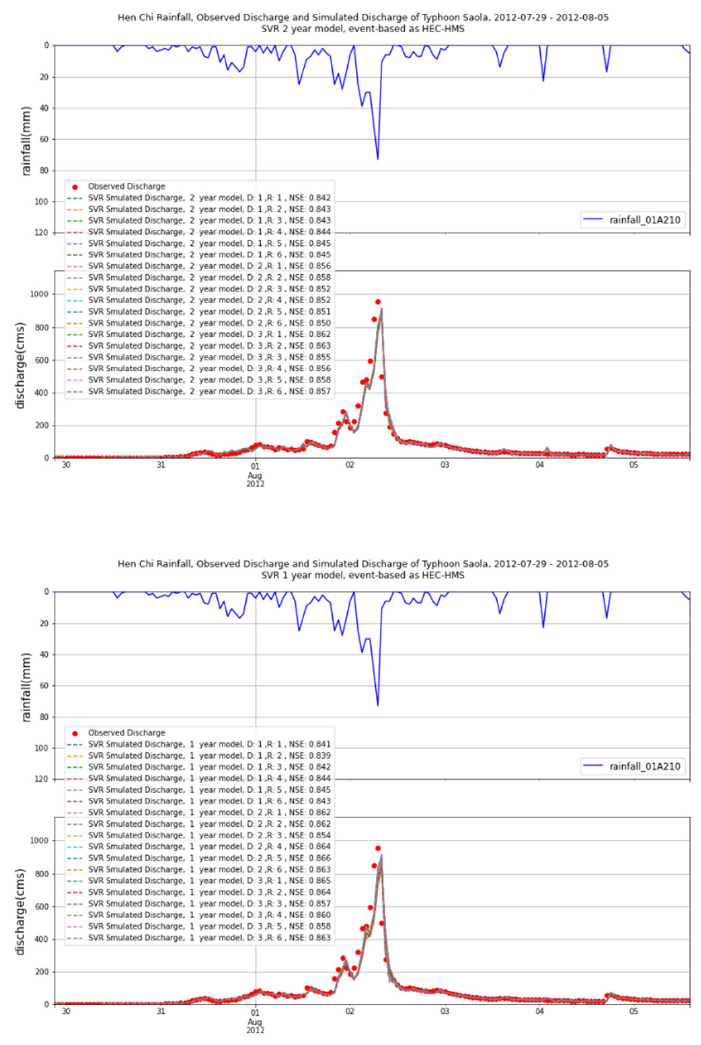
Figure 8. The testing results derived from the Type 2 SVR model using different features selection for Typhoon Saola. D 1 to 3 represents discharge features of the previous 1 to 3 h, while R 1 to 6 indicates rainfall features of the previous 1 to 6 h.